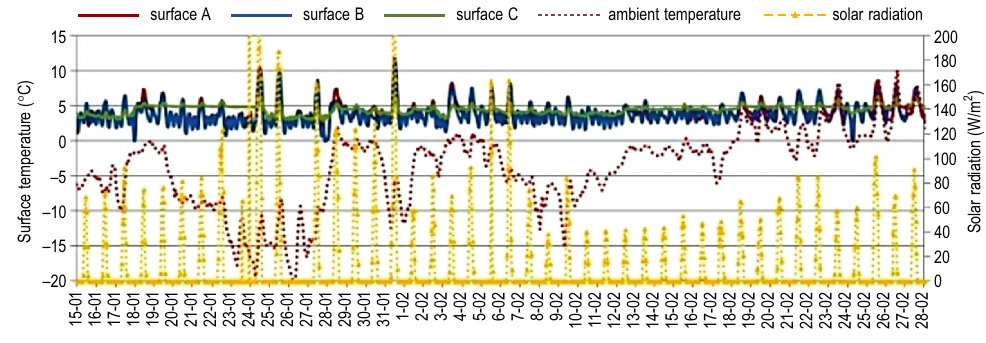
Fig. 9. Surface temperature for different heating surfaces resulting from control strategy t surf = 3 °C with ambient temperature and solar radiation for investigated period